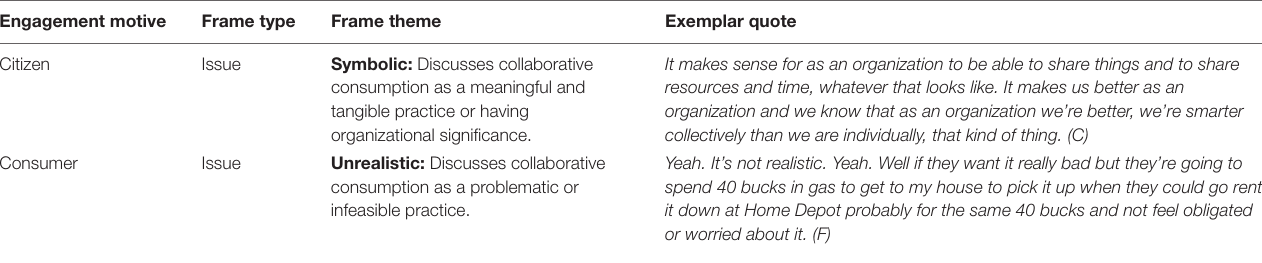
TABLE 4 | Issue framing based on engagement